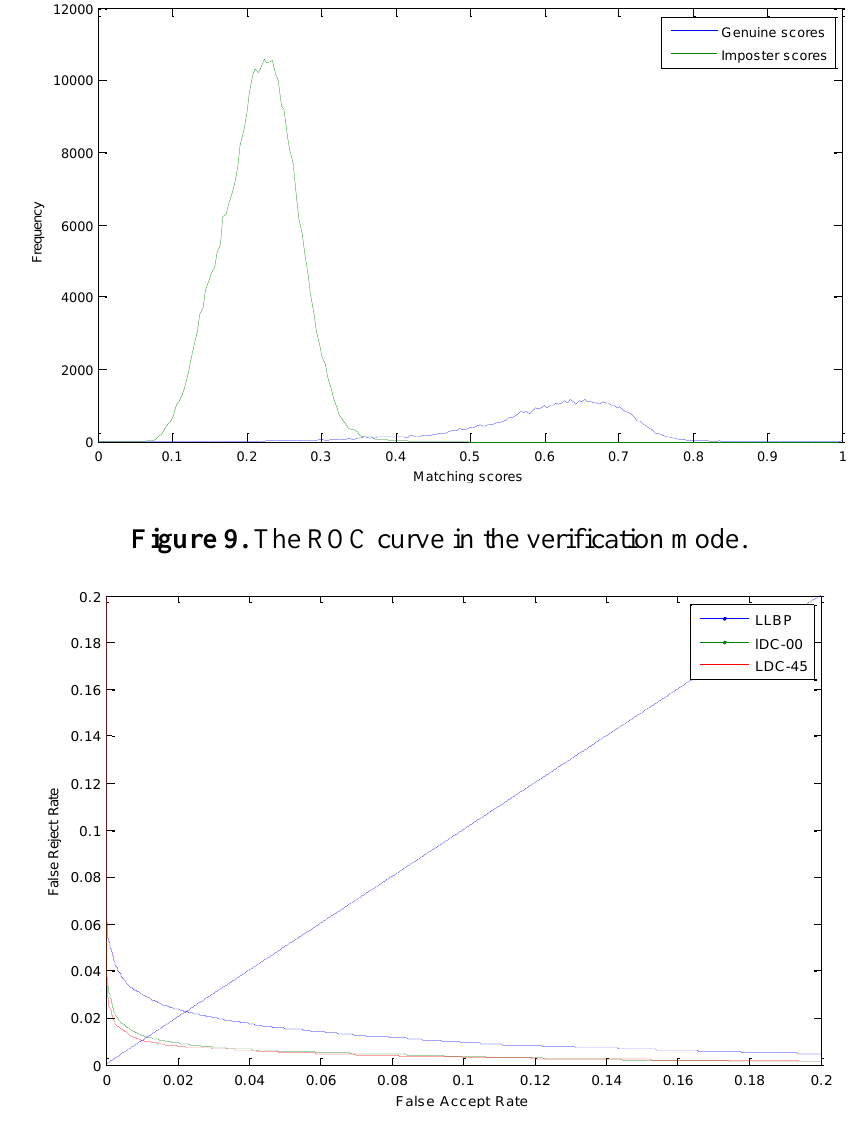
Figure 8. Matching score distribution of the LDC-45-based finger vein recognition.